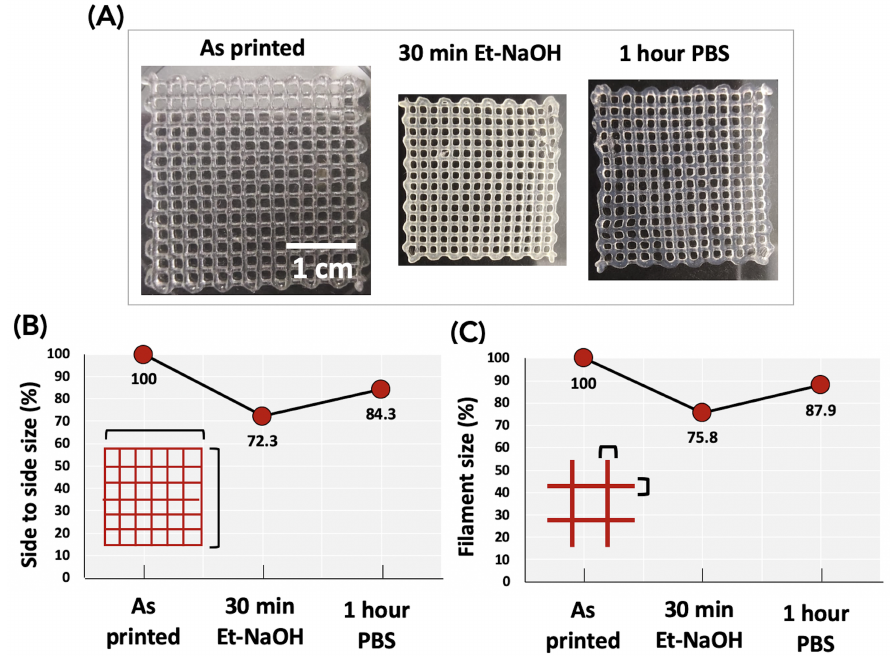
Figure 3. Shrinkage of 3D-bioprinted constructs after immersion in a gelling solution (ethanol and NaOH) for 30 min and subsequent swelling in PSB after 1 h. ( A ) Qualitative images of the shrinking and subsequent swelling processes. ( B ) Quantification of the variation in overall size (from side to side) of the membranes. ( C ) Quantification of the variation in filament